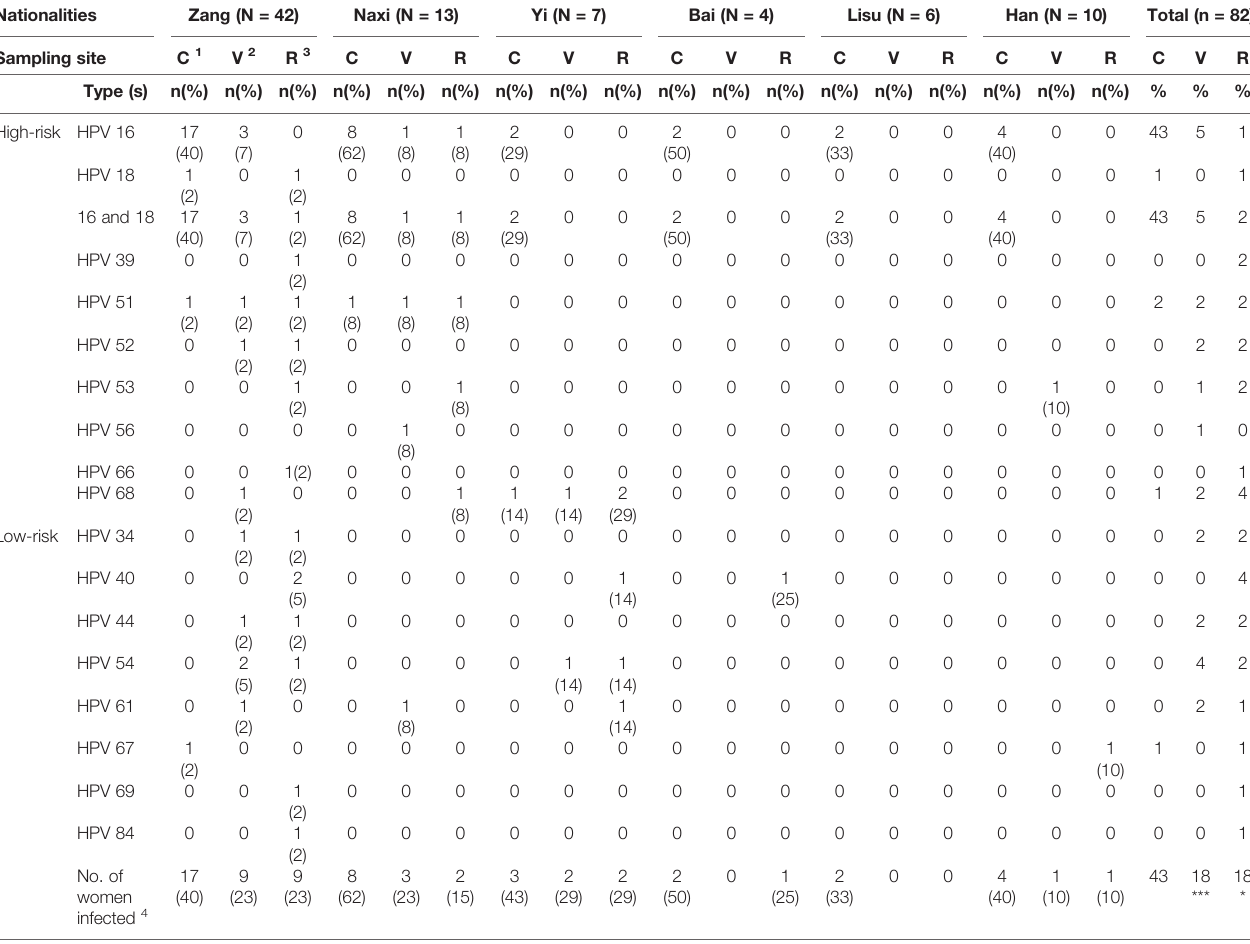
TABLE 2 | Type-speci fi c HPV prevalence by cytology triage test result. Nationalities